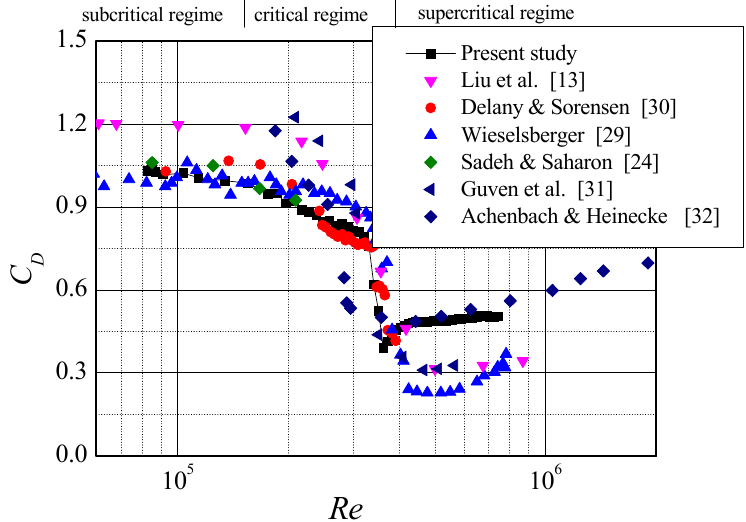
Figure 15. Drag coe ffi cient of circular cylinder in the smooth flow. Figure 15 . Drag coefficient of circular cylinder in the smooth flow.